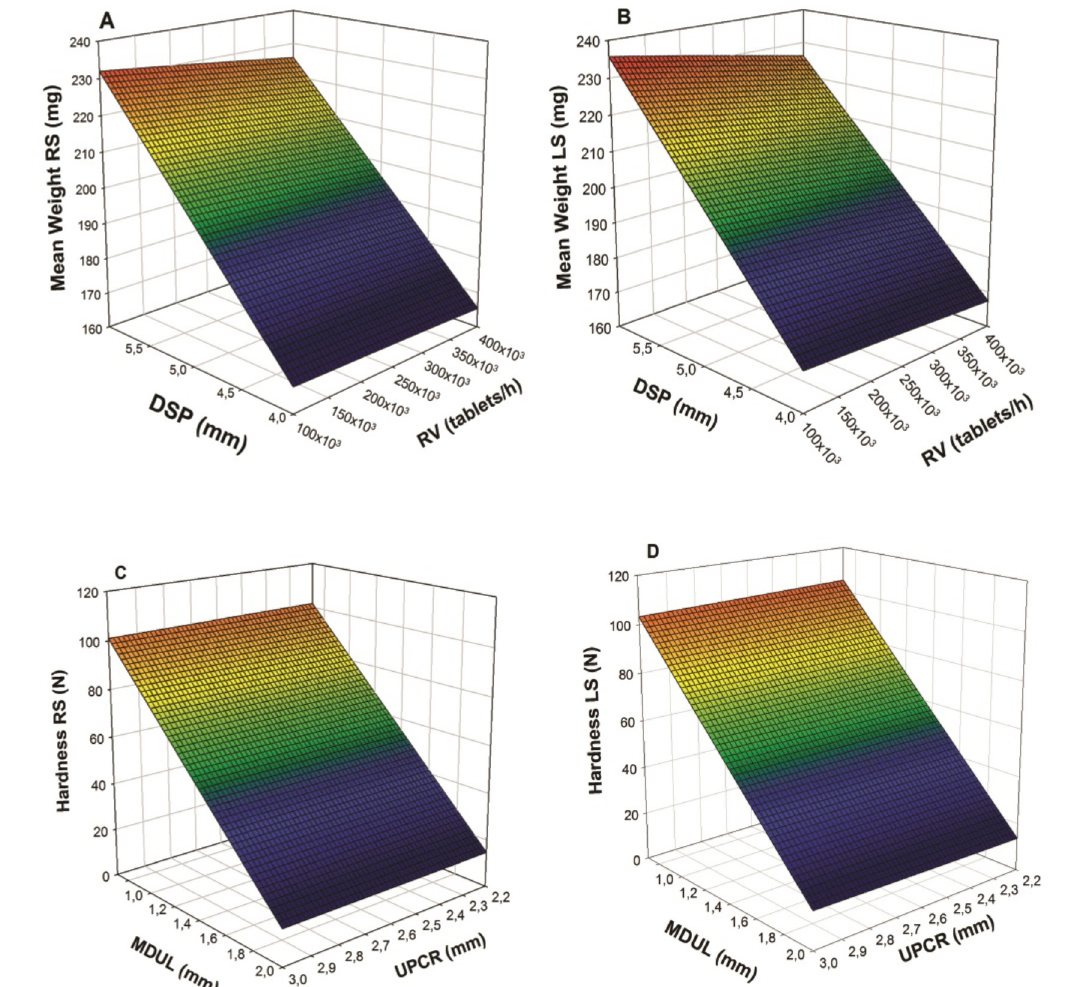
FIGURE 2 - Response surface graph of (A) mean weight RS vs DSP vs RV; (B) mean weight LS vs DSP vs RV; (C) hardness RS vs MDUL vs UPCR; (D) hardness LS vs MDUL vs UPCR. TABLE V - Mean weight equations for RS and LS of tablet machine Machine side